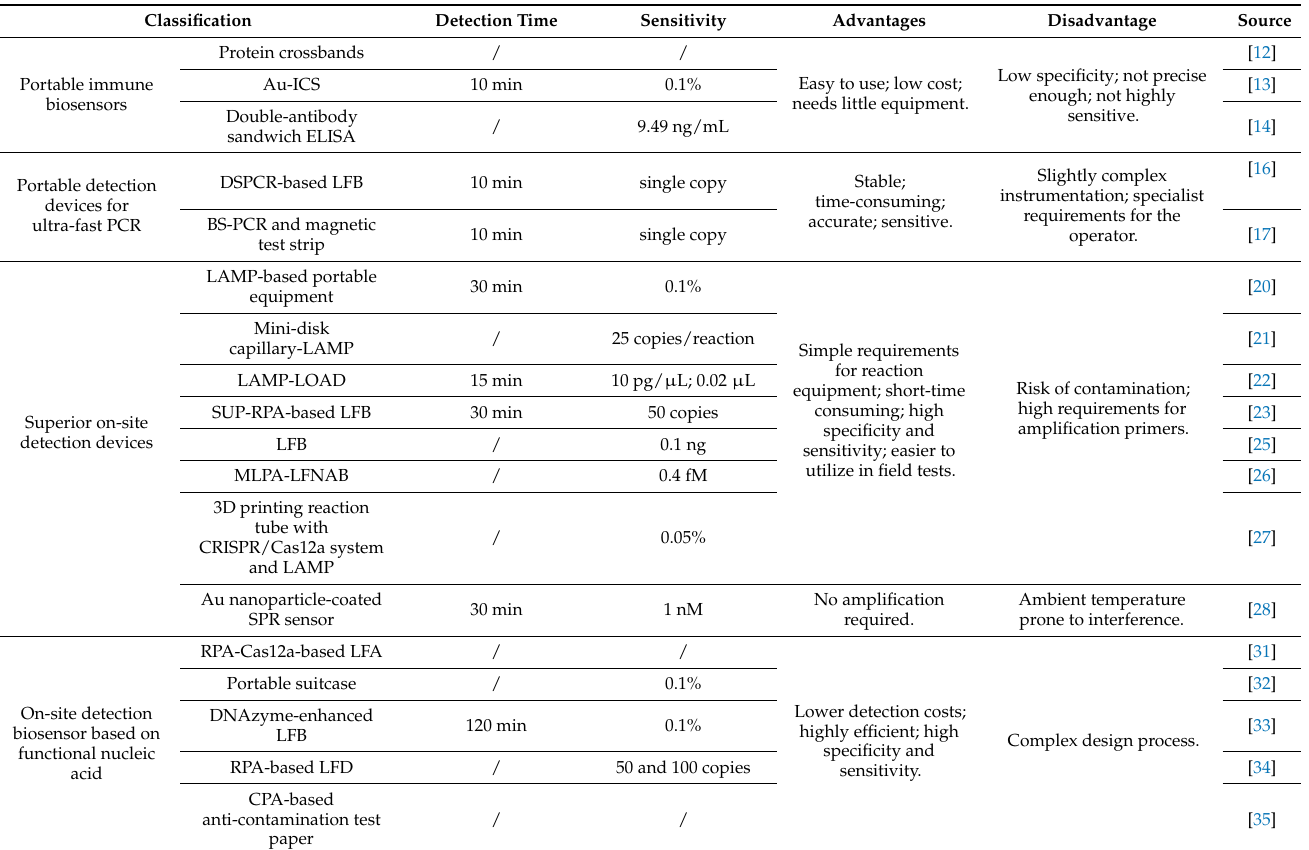
Table 1. Advantages and disadvantages of different detection